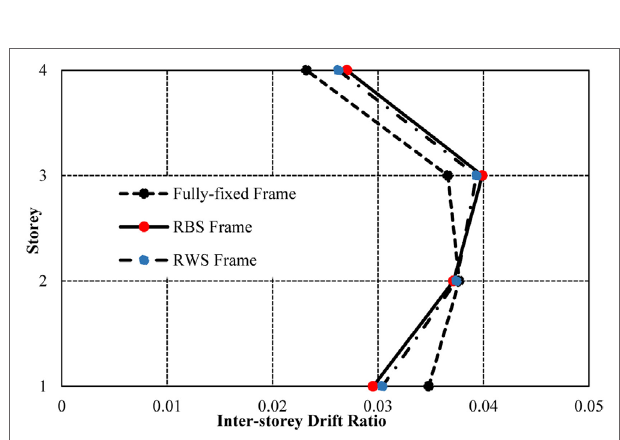
Figure 17 | Inter-storey drifts for 4-storey frame.